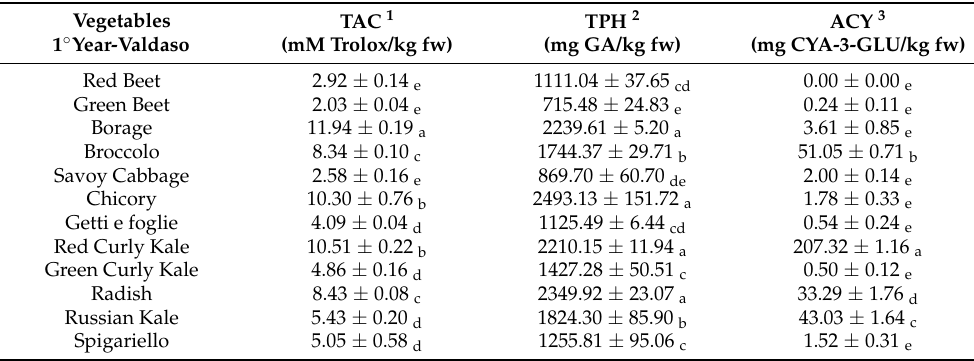
Table 6. Phenolics, anthocyanins contents, and antioxidant capacity in the different type of vegetables analyzed during 1st year in Valdaso.